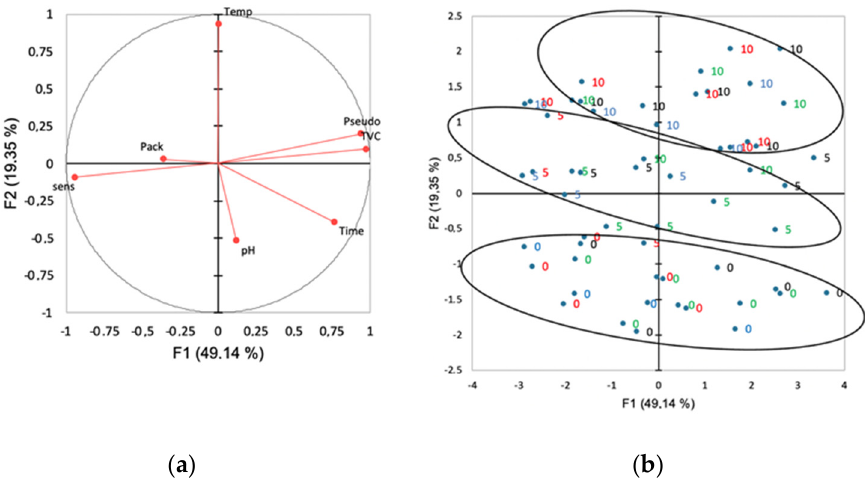
Figure 5. Principal component analysis output indicating the effect of packaging and storage conditions on the quality of fresh chicken cuts. ( a ) Variable plot: “Pack” refers to packaging type, “Temp” refers to storage temperature, “TVC” refers to total viable count load, “Pseudo” refers to Pseudomonas spp. load, “pH” refers to pH value, and “sens” refers to sensory scoring (overall impression). ( b ) Observation plot: Black refers to the control, green refers to MAP, blue refers to EC-flav, red refers to EC-glu, and numbers 0, 5, and 10 refer to storage temperature, i.e., 0, 5, and 10 °C, respectively.